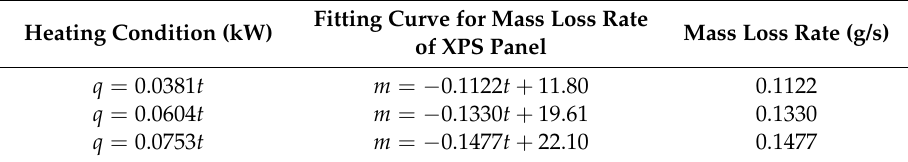
Figure 4. Mass of XPS panel exposed to different heat flux. Table 3. Fitting of mass loss rate curve in the mass rapid reduction stage under different heating condition.